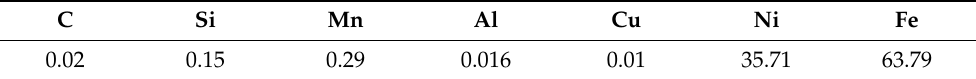
Table 1. Composition of the cold-drawn Invar Fe–Ni alloy wire with wt% ≥